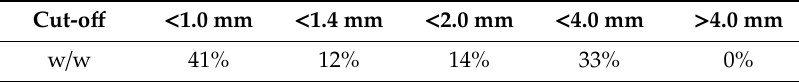
Table 1. Mass distribution of the fine fraction of the cha ff (N = 5).